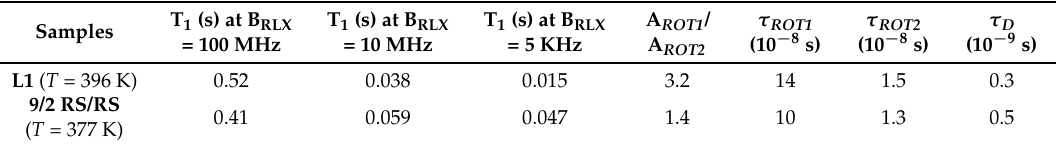
Table 2. Values of T 1 (s) at different frequencies (B RLX ) and relevant best fitting parameters of the 1 H NMR R 1 —dispersions for the two samples L1 and 9/2 RS/RS in the isotropic phase, as obtained by using Equations